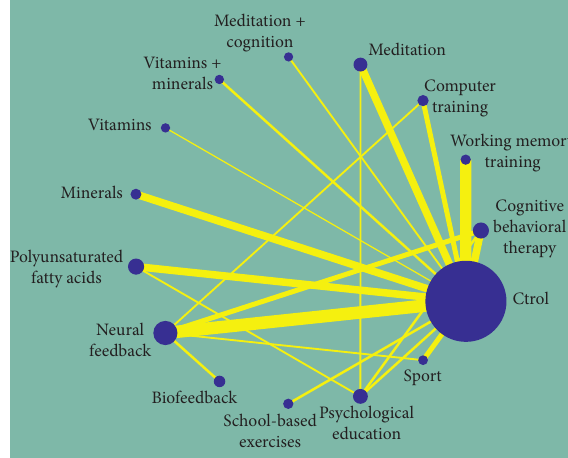
Figure 2: Network plot of meta-analysis.